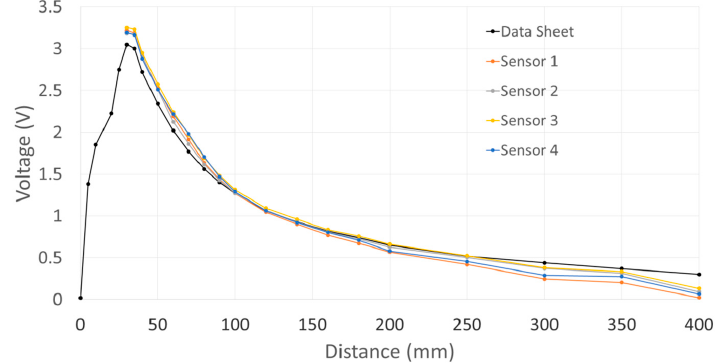
Figure 8. Characteristic response of individual IR range sensors.